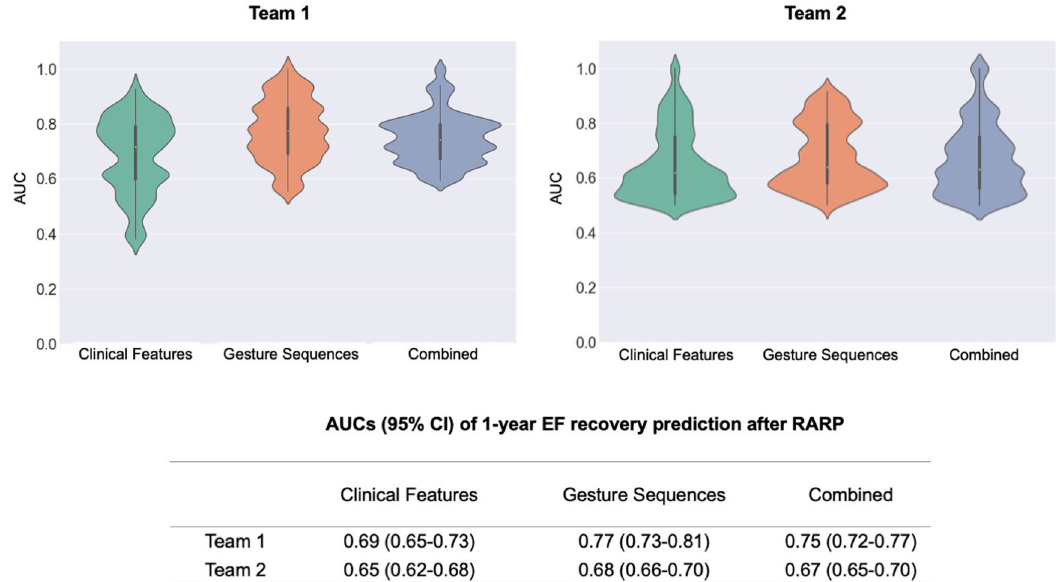
Fig. 4 Prediction model performance. Violin plots showing the performance of 1-year EF recovery prediction